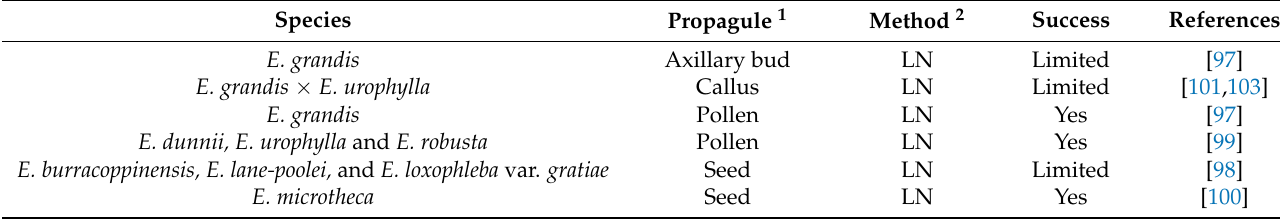
Table 2. Reported use of cryobiotechnology for ex situ conservation of Eucalyptus